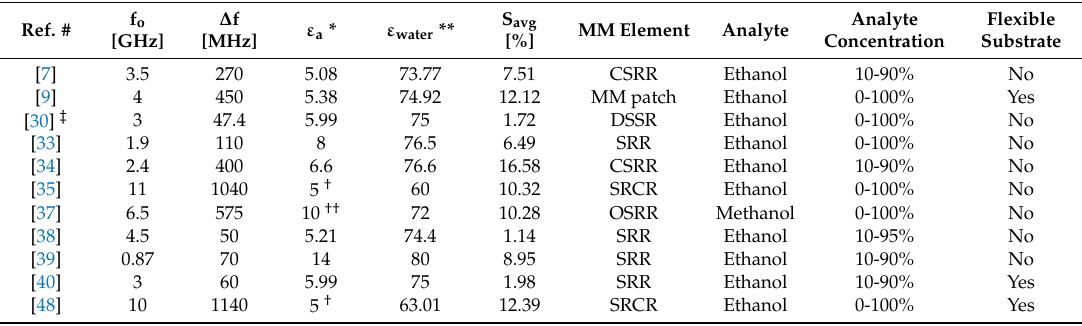
Table 2. Performance comparison of various metamaterial inspired microfluidic chemical sensors, presented in this review